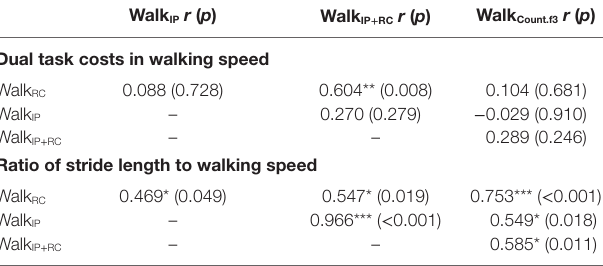
TaBle 6 | Correlation among rhythm-motor and cognitive-motor dual tasks.